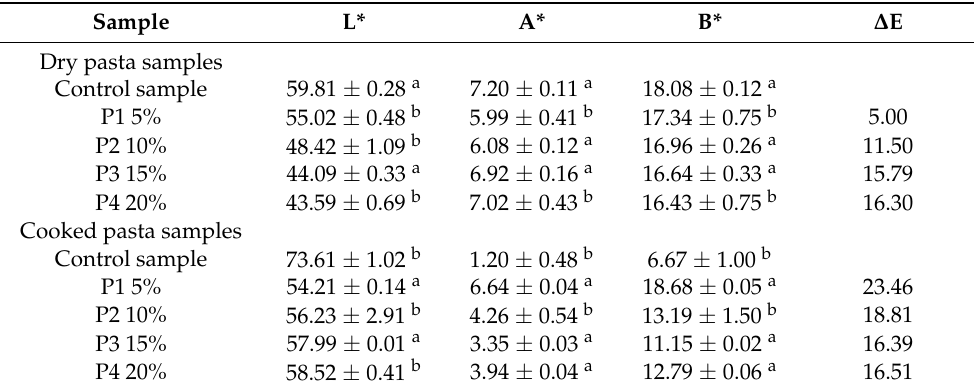
Table 3. Color characteristics of control and spent grain-containing pasta samples.